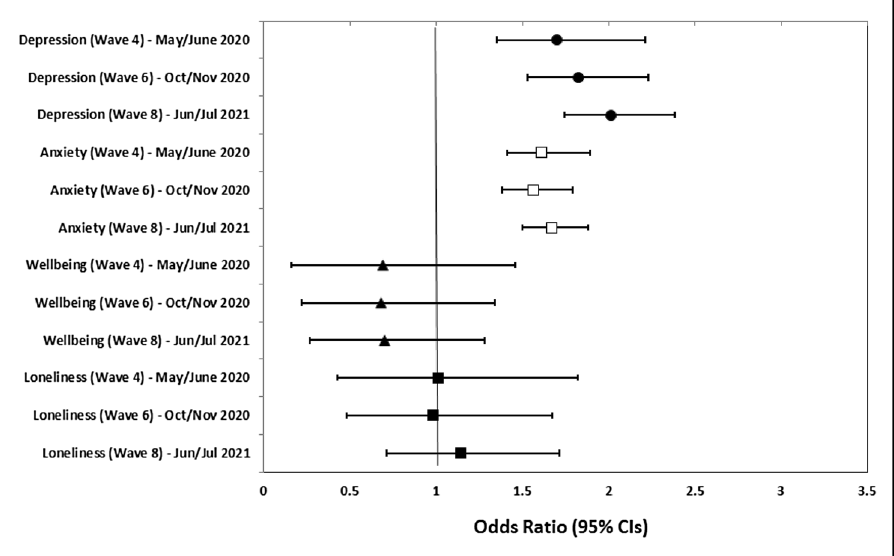
Figure 2. Associations between reporting probable COVID-19 infection during first 6 weeks of the UK national lockdown (Mar/May 2020) and clinically meaningful cut-offs for mental health outcomes at 1